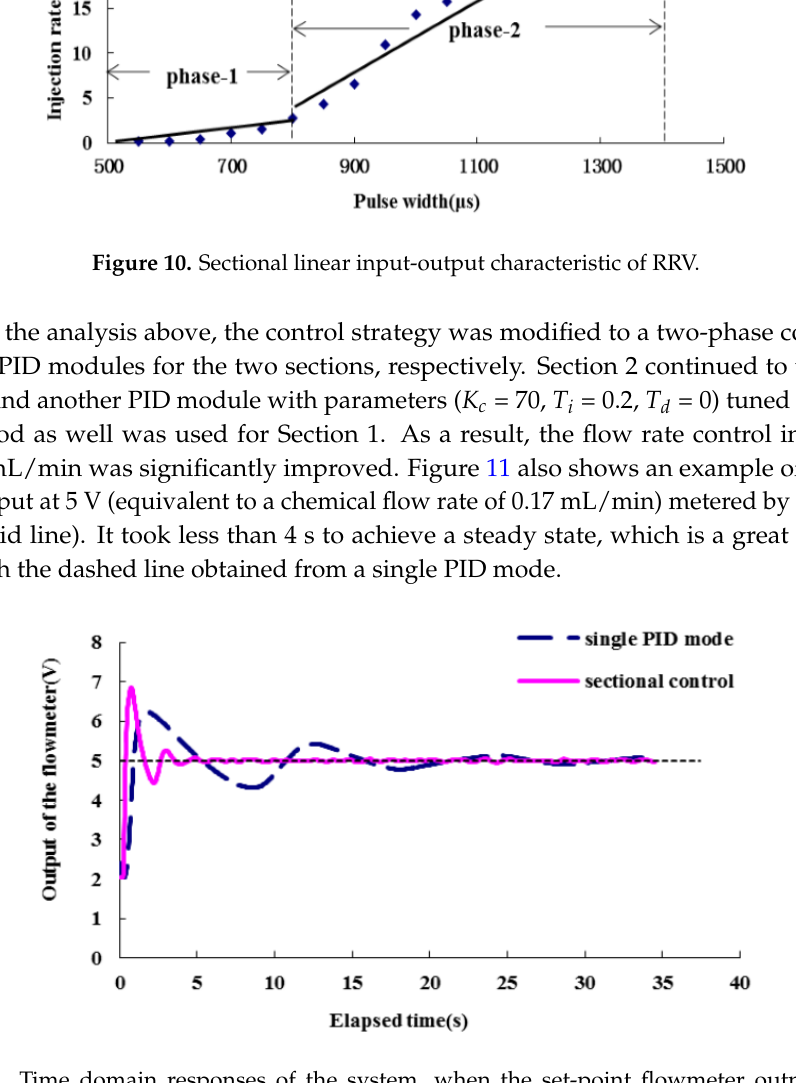
Figure 11. Time domain responses of the system, when the set-point flowmeter output is 5 V (equivalent to a chemical flow rate of 0.17 mL/min).